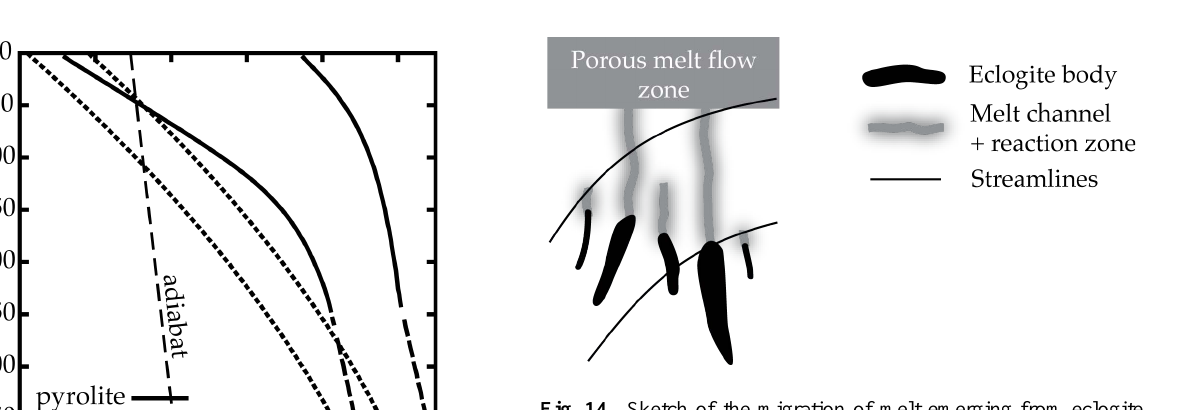
Fig. 12. Analysis of results from the model of Fig. 11. (b) Cumulative percentage of processed tracers (blue), (f) ages of MORB (blue) and OIB (red) samples. Both plots include the result from the sampling theory with variable processing time (magenta, dashed), and from the theory using constant process times: the initial processing time of 1.98Gyr (green, dashed) and the final processing time of 4.23Gyr (green, solid). The dash-dot line in (b) is the amount of degassing of 40 Ar relative to the total amount produced by the decay of 40 K.